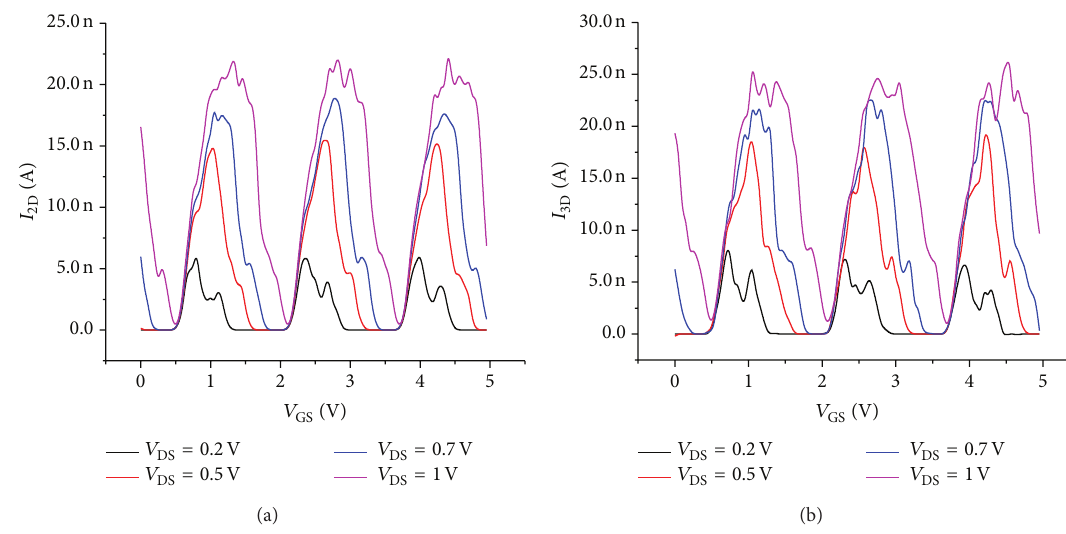
Figure 7: Gate current simulation at 300 K for different drain voltages, (a) 𝐼 2